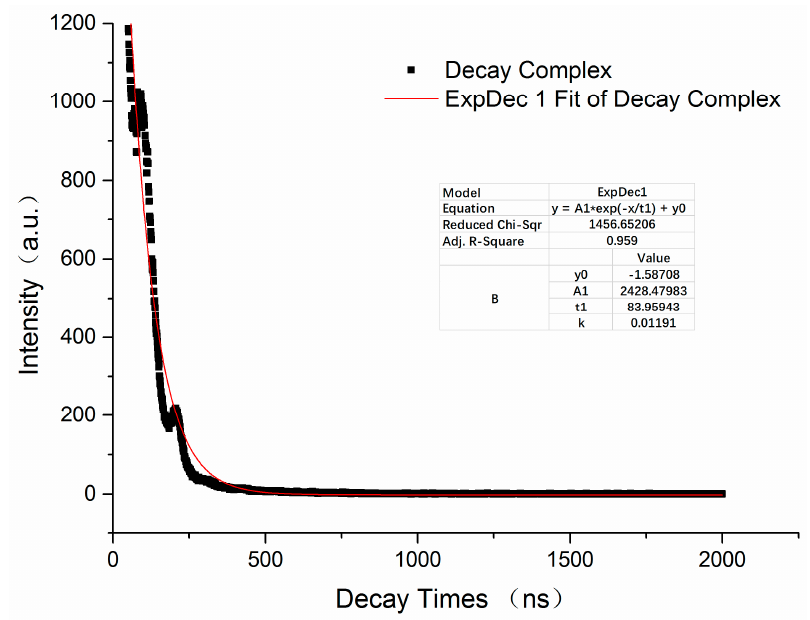
Figure 9. Luminescence decay curve for 1 (black line: experimental data; red line: fitting result).